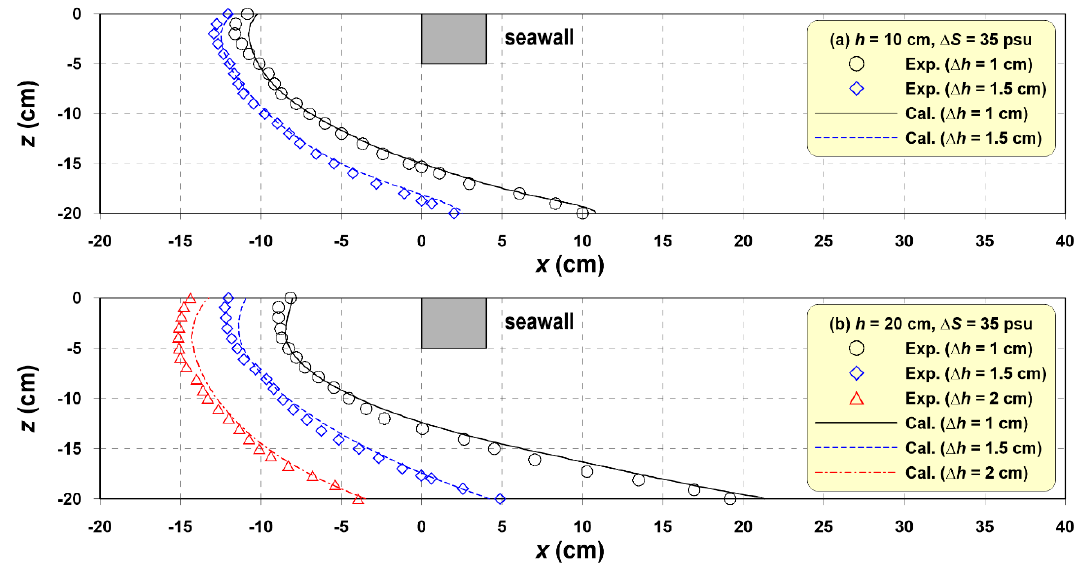
Figure 7. Comparisons between measured and calculated saltwater–freshwater interfaces for ( a ) h = 10 cm and ( b ) h = 20 cm at Δ S = 35 psu in a coastal aquifer with a seawall.